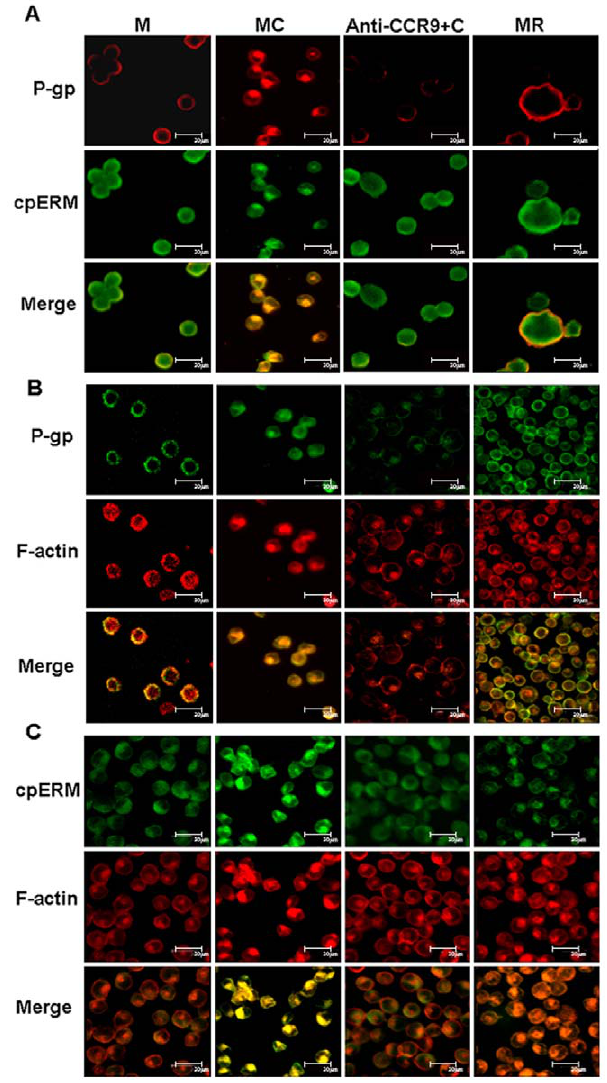
Figure 3. Colocalization of P-gp, p-ERM and F-actin in MOLT4 cells treated with CCL25 by confocal. Shown are the subcellular localizations of (A) P-gp (red) and p-ERM (green), (B) P-gp (green) and F- actin (red), and (C) p-ERM (green) and F-actin (red) in MOLT4 cells treated with CCL25 or anti-CCR9 and CCL25 together. All the images showed that P-gp and p-ERM or F-actin colocalized in CCL25 treated cells, and this colocalization could be abolished by anti-CCR9 antibody. Bar=20 m m. The results represented the means of four independent experiments.